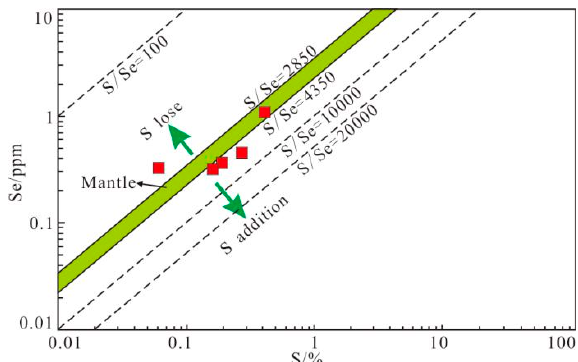
Figure 11. Contamination diagram of S-Se showing an extra sulfur adding to the magma in the Niubiziliang Ni-(Cu) deposit (modified after Smith et al. (2016) [34]). Table 5. Concentrations of S, Se, and Te from the Niubiziliang mafic-ultramafic complex. Sample Rock Type